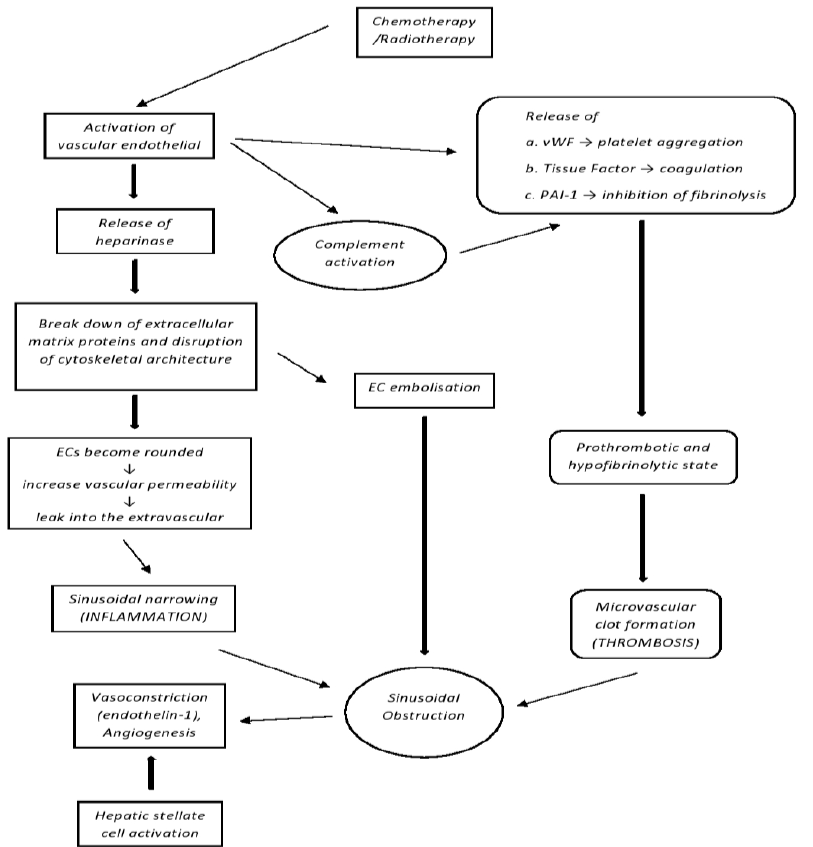
Figure 1. Pathogenesis of SOS/VOD, chemotherapy, and radiation injure endothelial cells (ECs), activate both them and their complement, and disrupt cytoskeletal architecture. Fluid and blood elements enter the extravascular space of Disse and nearby tissues, promoting sinusoidal narrowing, decrease in blood flow, and obstruction.